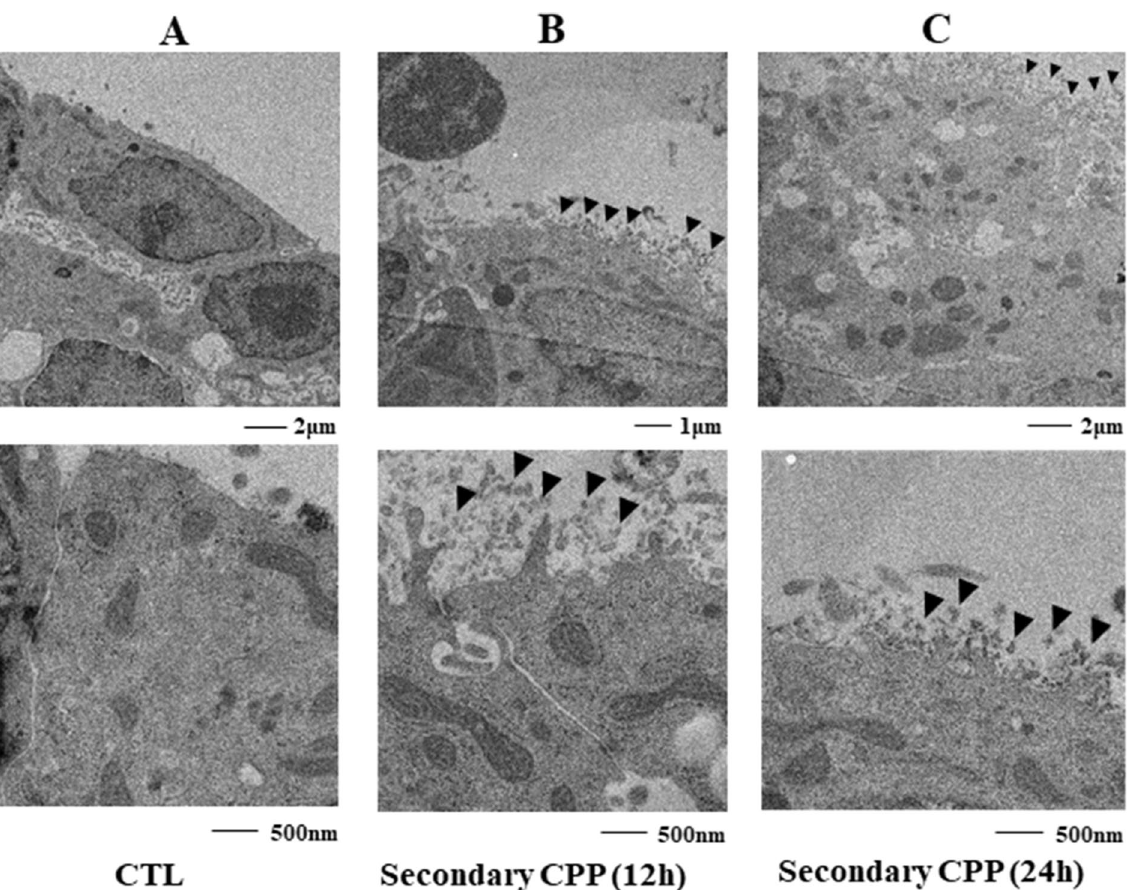
Figure 3. Localization of secondary CPP in HepG2 cells. HepG2 cells without incubation with secondary CPP ( A ) and 12 h ( B ) and 24 h ( C ) after addition of 100 μg/mL secondary CPP. TEM imaging showed extracellular crystalline-like structures (arrowhead) around treated HepG2 cells ( B , C ), whereas no such structure was present in control cells ( A